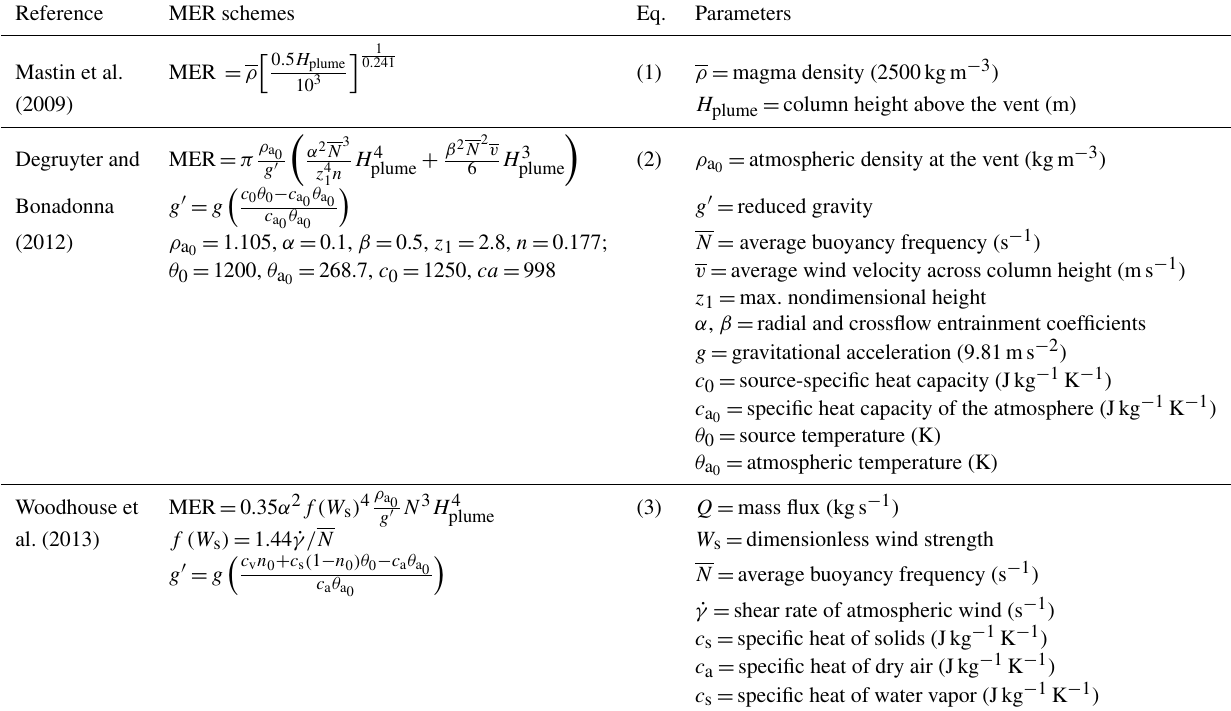
Table 2. Options implemented in NMMB-MONARCH-ASH to estimate the mass eruption rate from column height. Unless otherwise noted, the units for all parameters are in